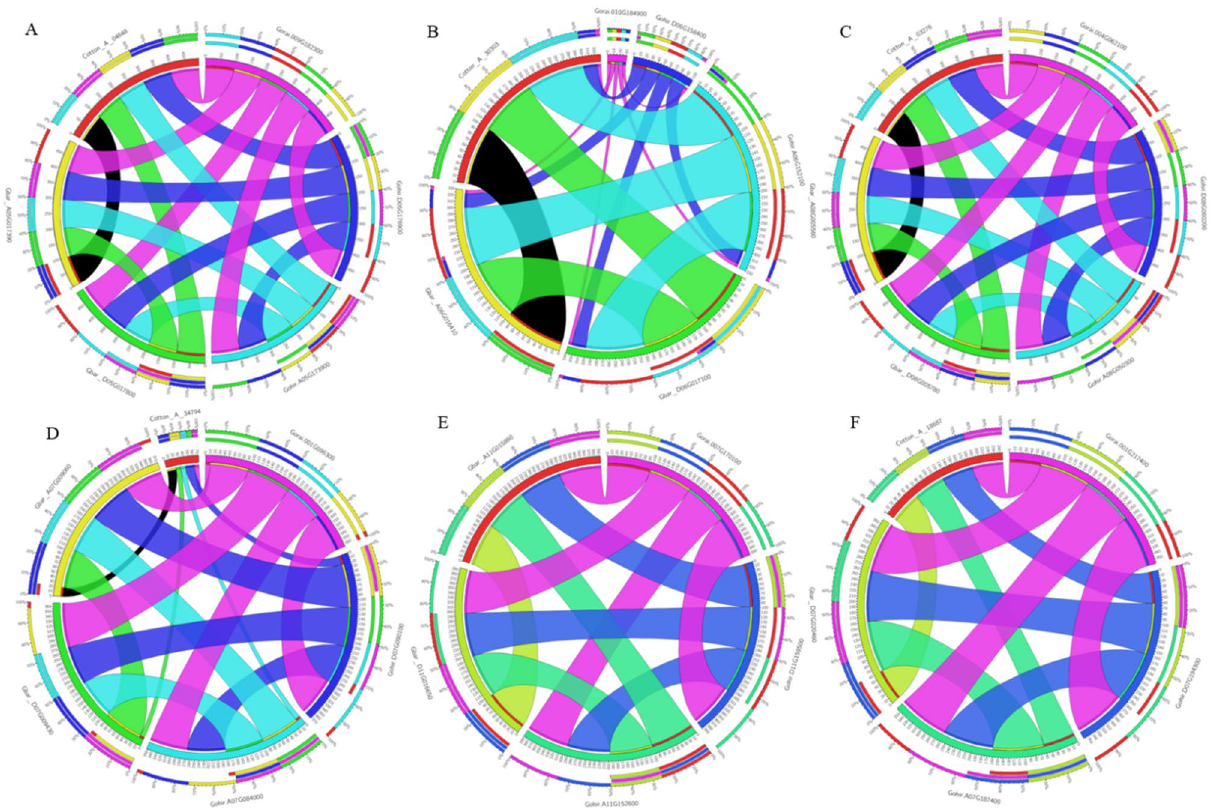
Figure 5. Sub-genomic characterization of ACO (1-aminocyclopropane-1-carboxylate oxidase) subfamilies ( A ) ACO1, ( B ) ACO2, ( C ) ACO3, ( D ) ACO4, ( E ) ACO3-like, ( F ) ACO4-like. The thickness of the bands represents the percent homology while the colors of the band represent the cotton species from which they